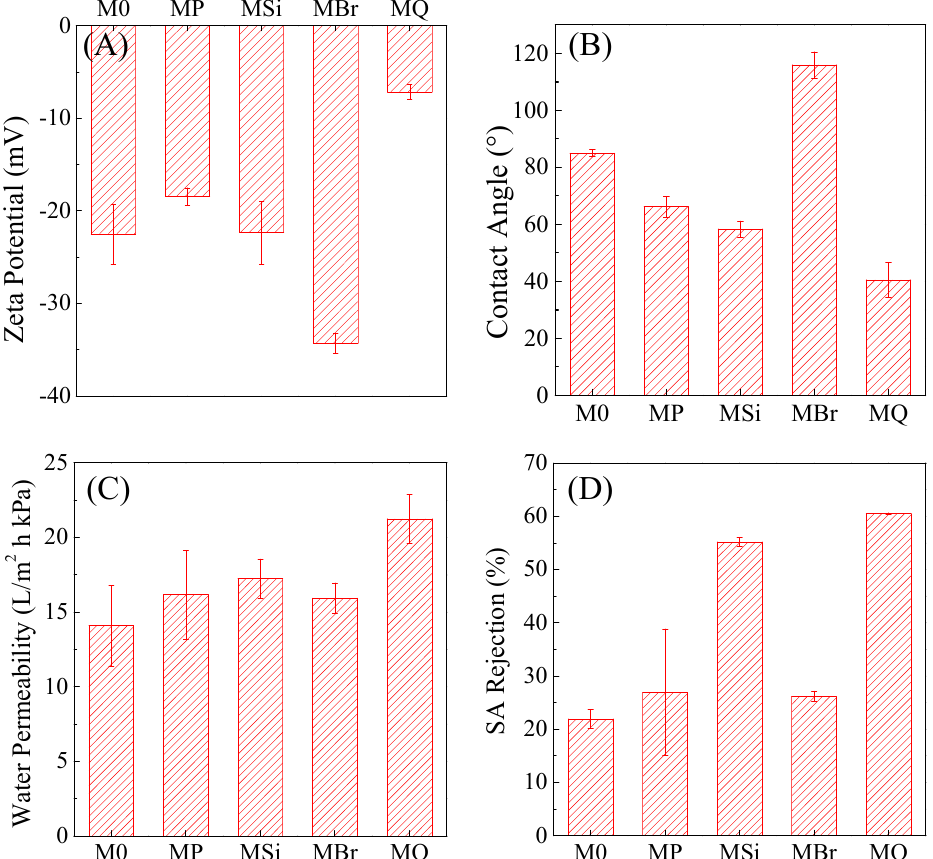
Figure 4. Characterization of membrane properties. ( A ) Zeta potential, ( B ) Contact angle of DI water, ( C ) Water permeability (10 kPa), ( D ) SA rejection. The number of measurements: n = 3 for zeta potential, water permeability and SA rejection; n = 7 for contact angle.